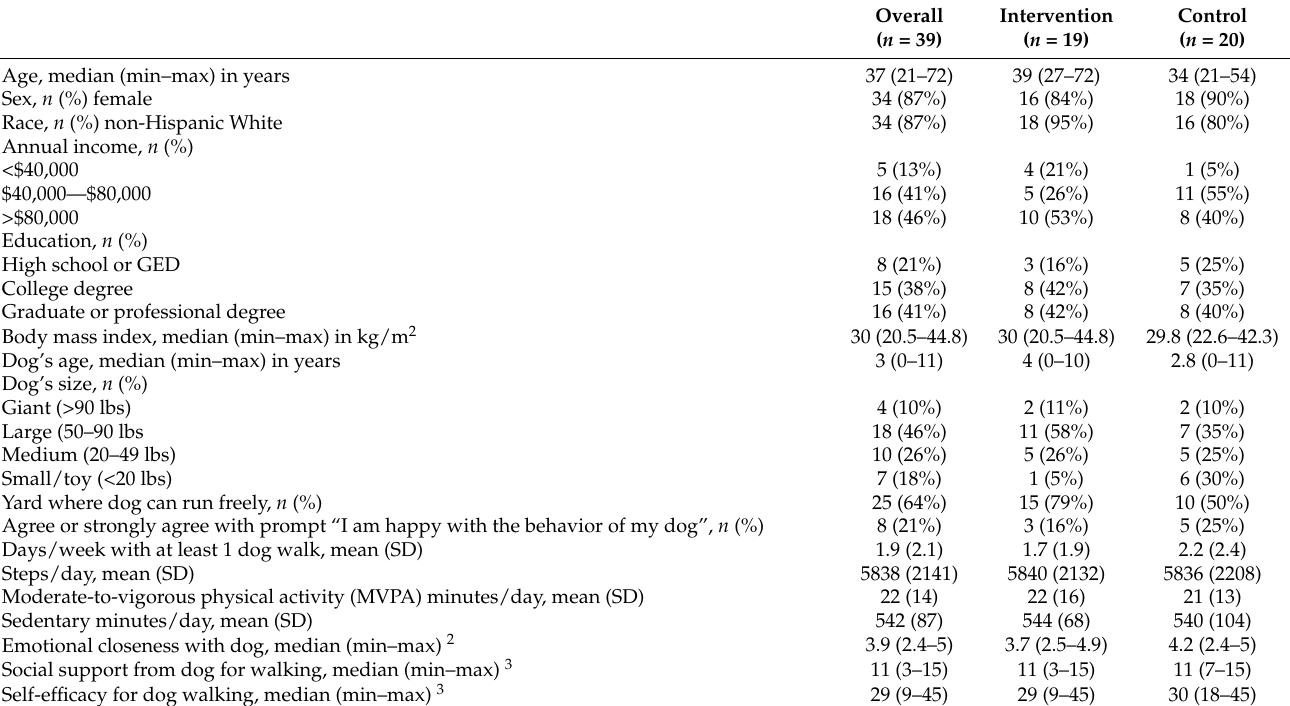
Table 1. Baseline characteristics of Stealth Pet Obedience Training (SPOT) study participants and their dogs.